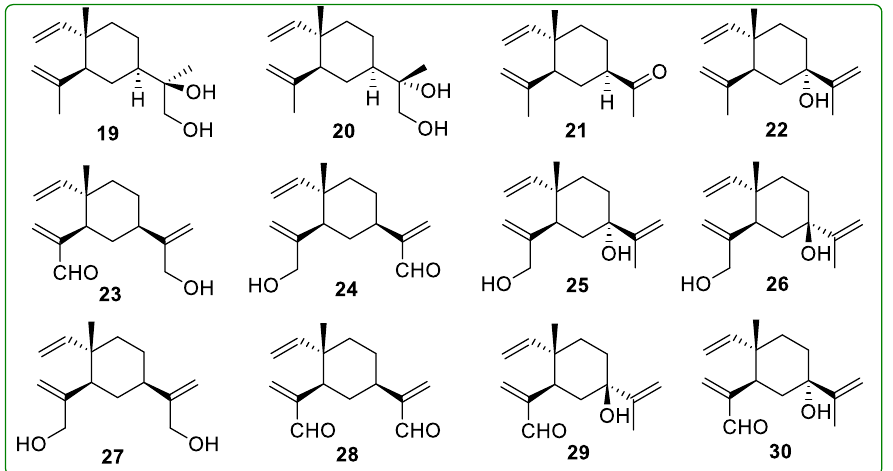
Figure 4. Chemical structures of β -elemene oxidation derivatives 7 – 18 .